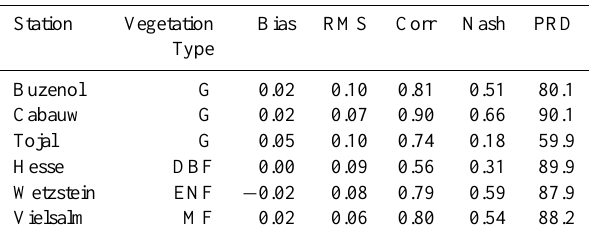
Table 3. Comparison between LSA-SAF ET and observed ET at validation stations: statistical results (Bias [mm h − 1 ], RMS [mm h − 1 ], correlation coefficient (Corr), Nash index, PRD criterion (see text) [%]); vegetation type: Grassland (G), Deciduous Broadleaved Forest (DBF), Evergreen Needleleaved Forest (ENF), Mixed Forest